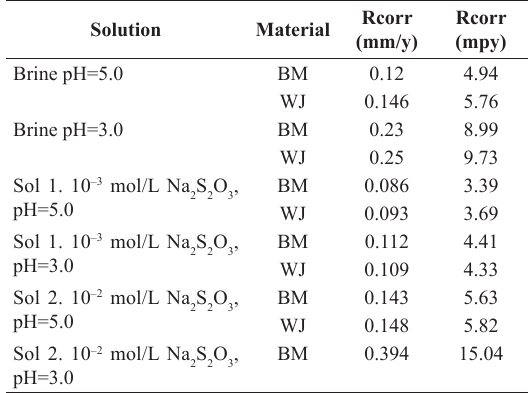
Table 3. Average corrosion rate obtained from the weight loss tests in different environments